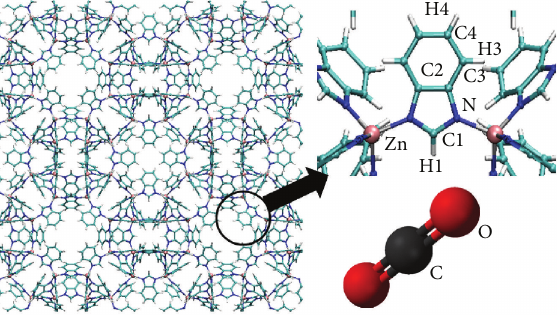
Figure 1: The topologies of ZIF-11, [C 7 H 5 N 2 ] − , and CO 2 .